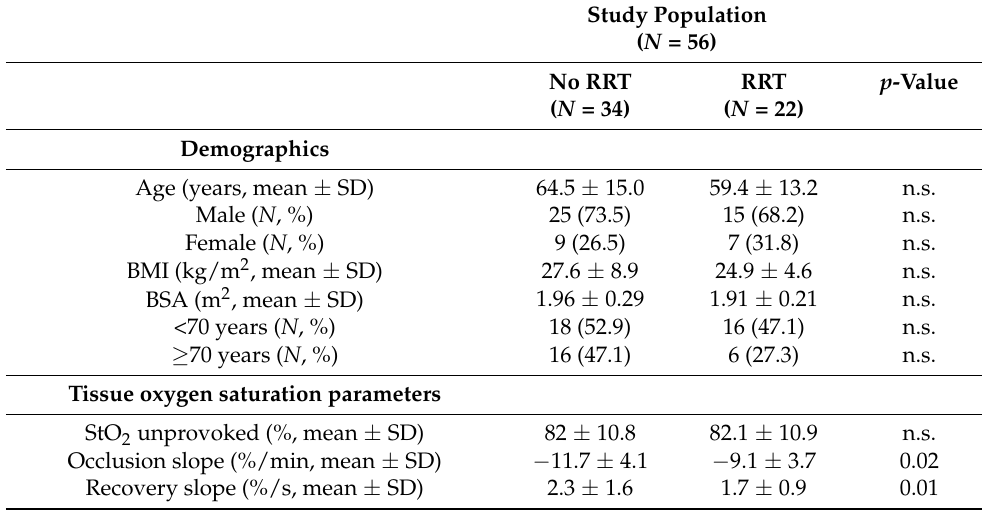
Table 1. Baseline data of the total study population regarding RRT